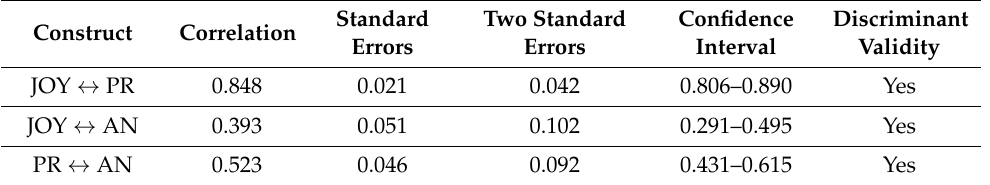
Table 7. Confidence interval of the scale (the 1st wave): the confidence interval (CI) correlation of two constructs ( ± two standard errors) not including 1.0 provided support for discriminative validity.